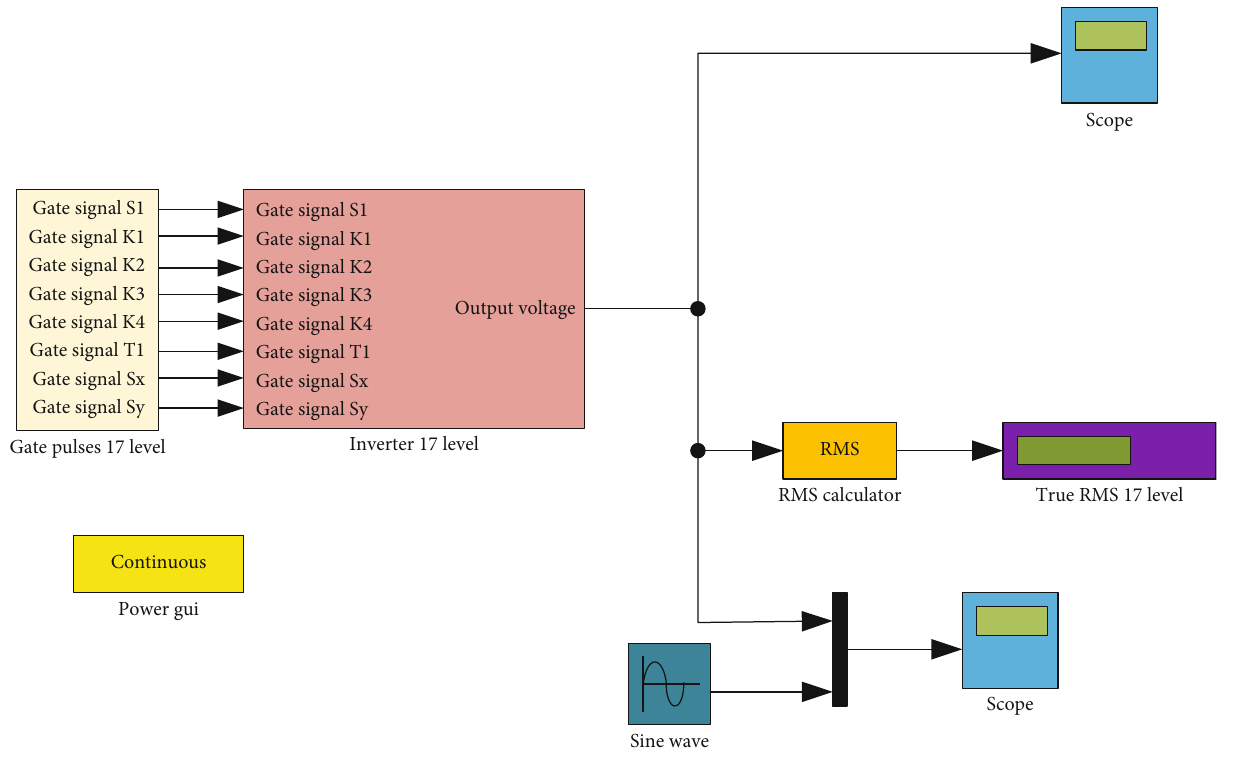
Figure 24: 17-level multilevel inverter.